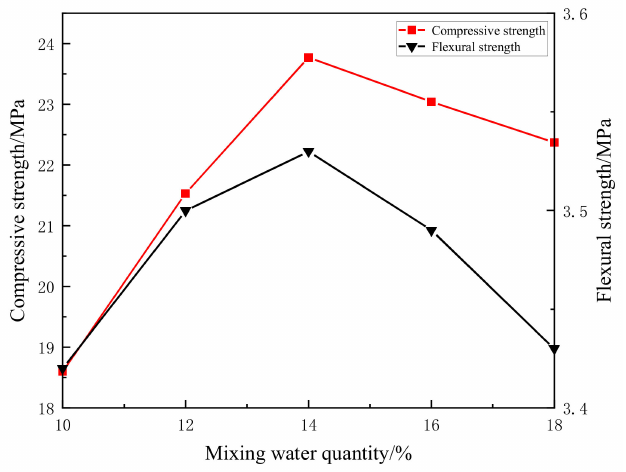
Figure 8. Compressive and flexural properties of aluminum dross non-fired bricks under different mixing-water amounts.